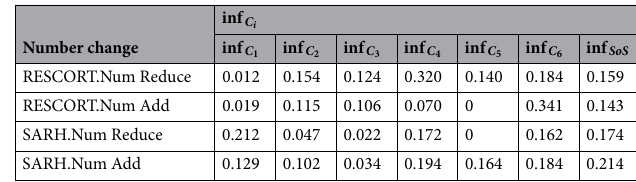
Table 11. Influence degree value of each sub-capability when changing the number of